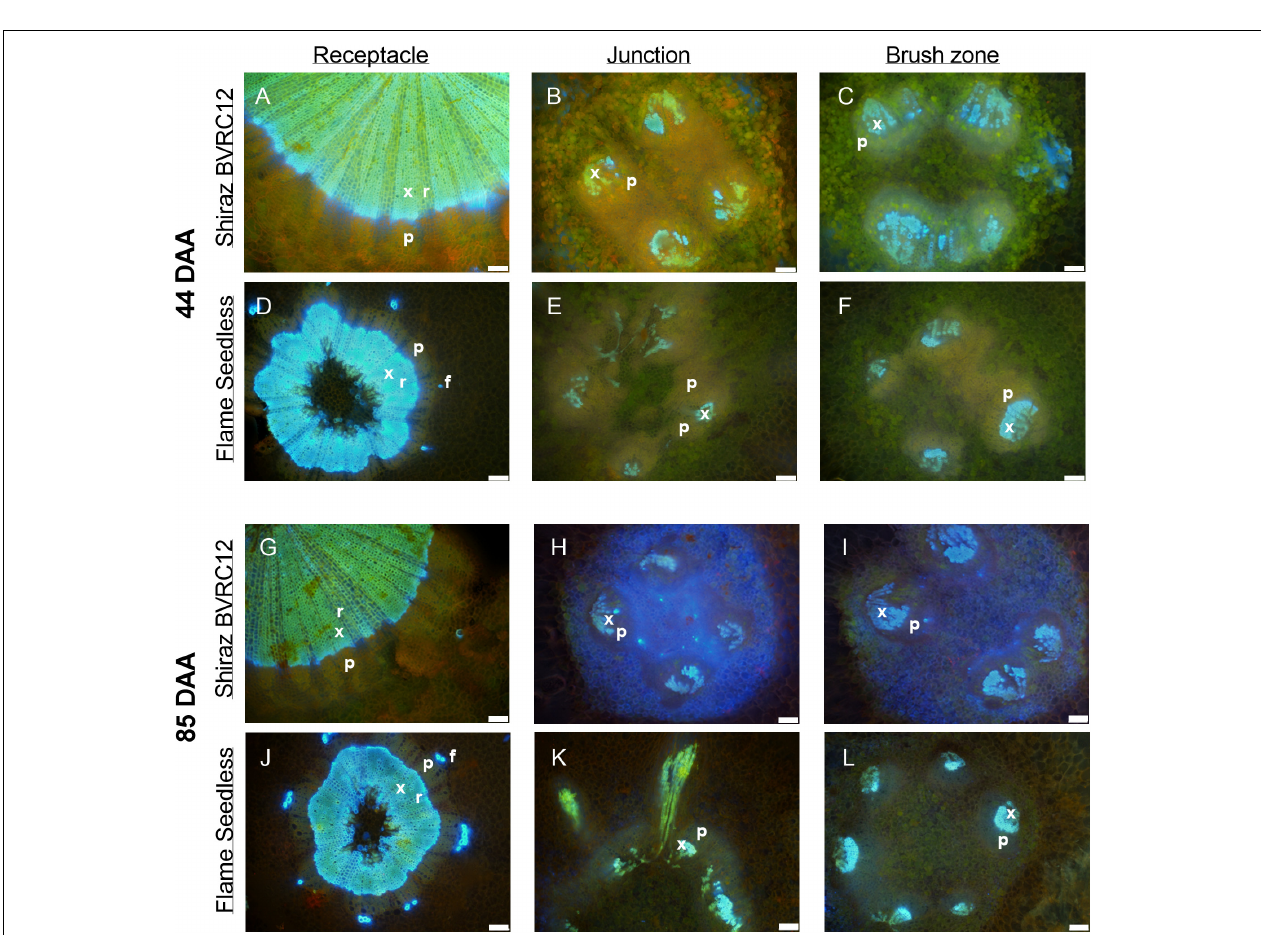
FIGURE 4 | Sections of receptacles (A,D,G,J) , receptacle/berry junction (B,E,H,K) , brush zone (2–4 mm from junction) (C,F,I,L) , stained with acridine orange and imaged under UV, of methanol stored Shiraz BVRC12 (A–C,G–I) and Flame Seedless (D–F,J–L) at around 44 (pre-veraison) and 85 (post-veraison) days after anthesis (DAA) in the 2017/2018 season. Bright blue indicates lignin (xylem and phloem fiber), pinkish orange indicates the location of phloem (x, xylem; p, phloem; r, xylem ray; f, phloem fiber). Excitation filter 330–385 nm, dichroic mirror 400 nm, barrier filter 420 nm. Scale bar = 100 µ m.